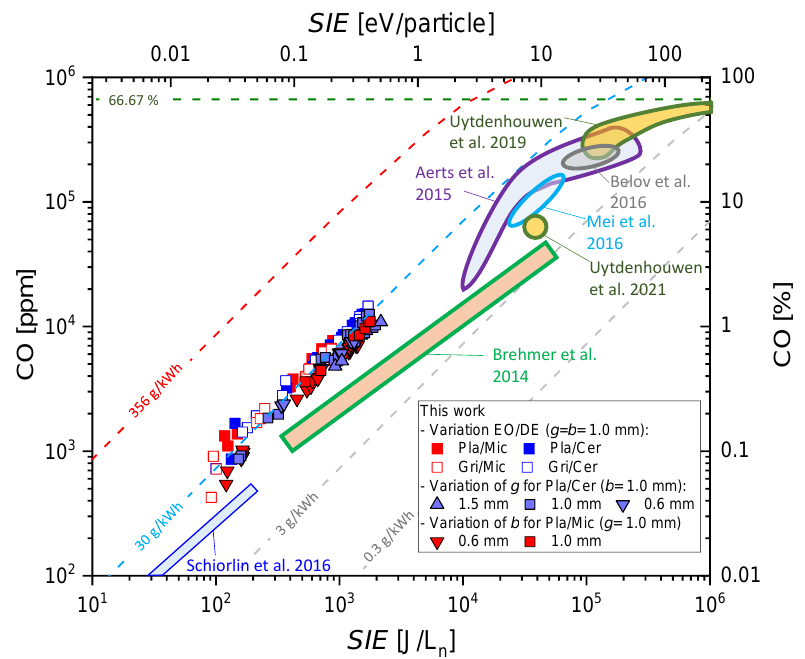
Figure 12. CO fraction as a function of SIE in the different DBD reactors in comparison with results from literature, namely, Brehmer et al. [29], Aerts et al. [14], Mei et al. [16], Belov et al. [21], Uytdenhouwen et al. [24,31] and Schiorlin et al. [48].